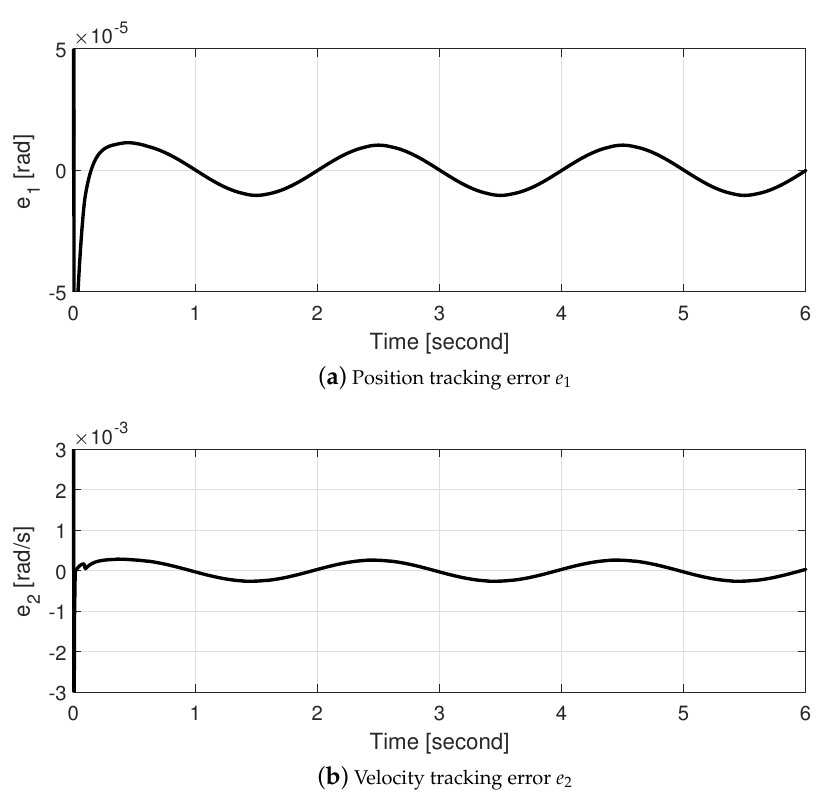
Figure 5. Position and velocity tracking errors of the proposed method.